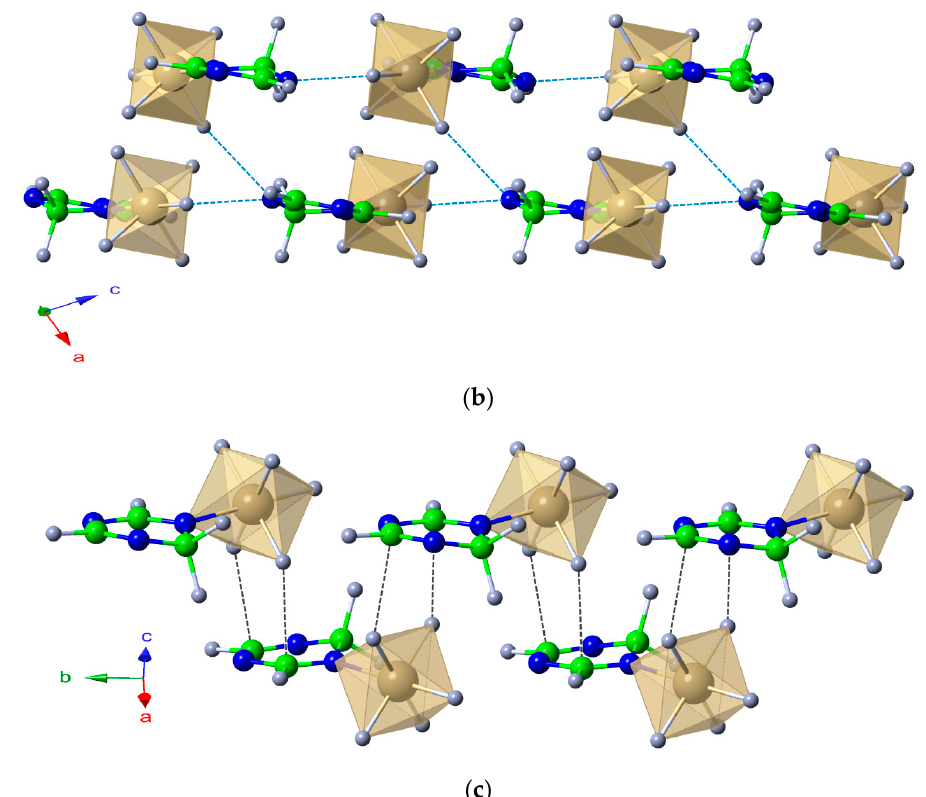
Figure 5. Intermolecular interaction: ( a ) F···F; ( b ) F···N; ( c ) F···C in complex 1 .